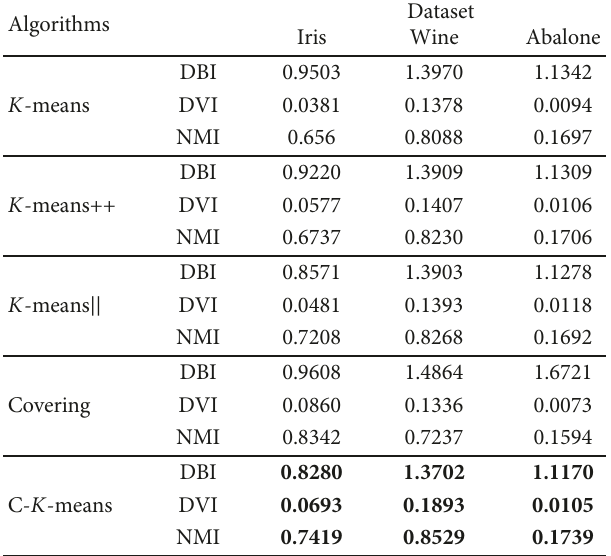
Table 5: Accuracy comparison (Iris, Wine, and Abalone). Algorithms